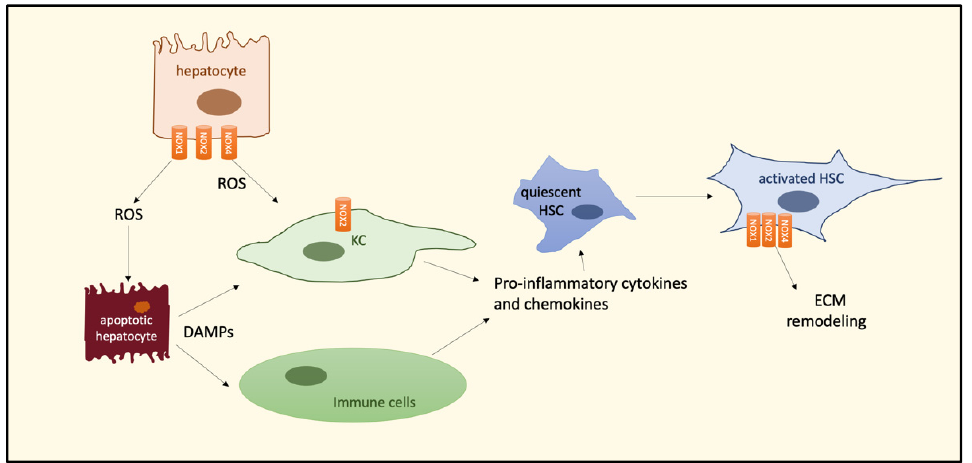
Figure 3. Schematic representation of NOX-induced ROS pathways leading to ECM remodeling during HCC development. NOXs isoforms are differently expressed in hepatic cells involved in NASH–fibrosis–HCC progression. Abbreviations: NADPH oxidase, NOX; hepatic stellate cell, HSC; Kupffer cell, KC; reactive oxygen species, ROS; damage-associated molecular patterns, DAMPs; extracellular matrix, ECM.